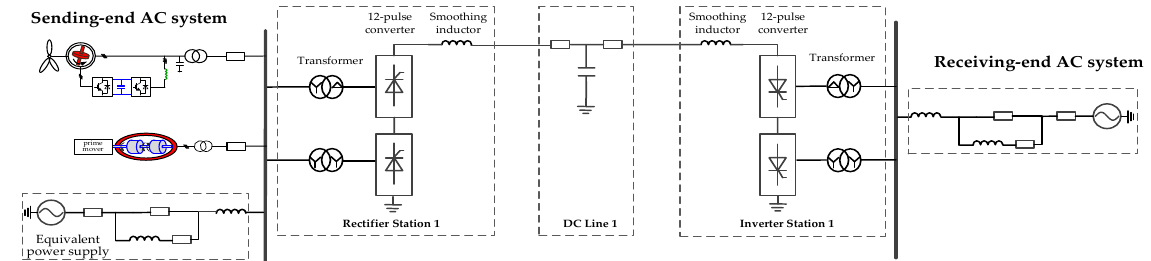
Figure 1. Structure of doubly fed induction generator (DFIG) wind farm connected with series compensated transmission network.